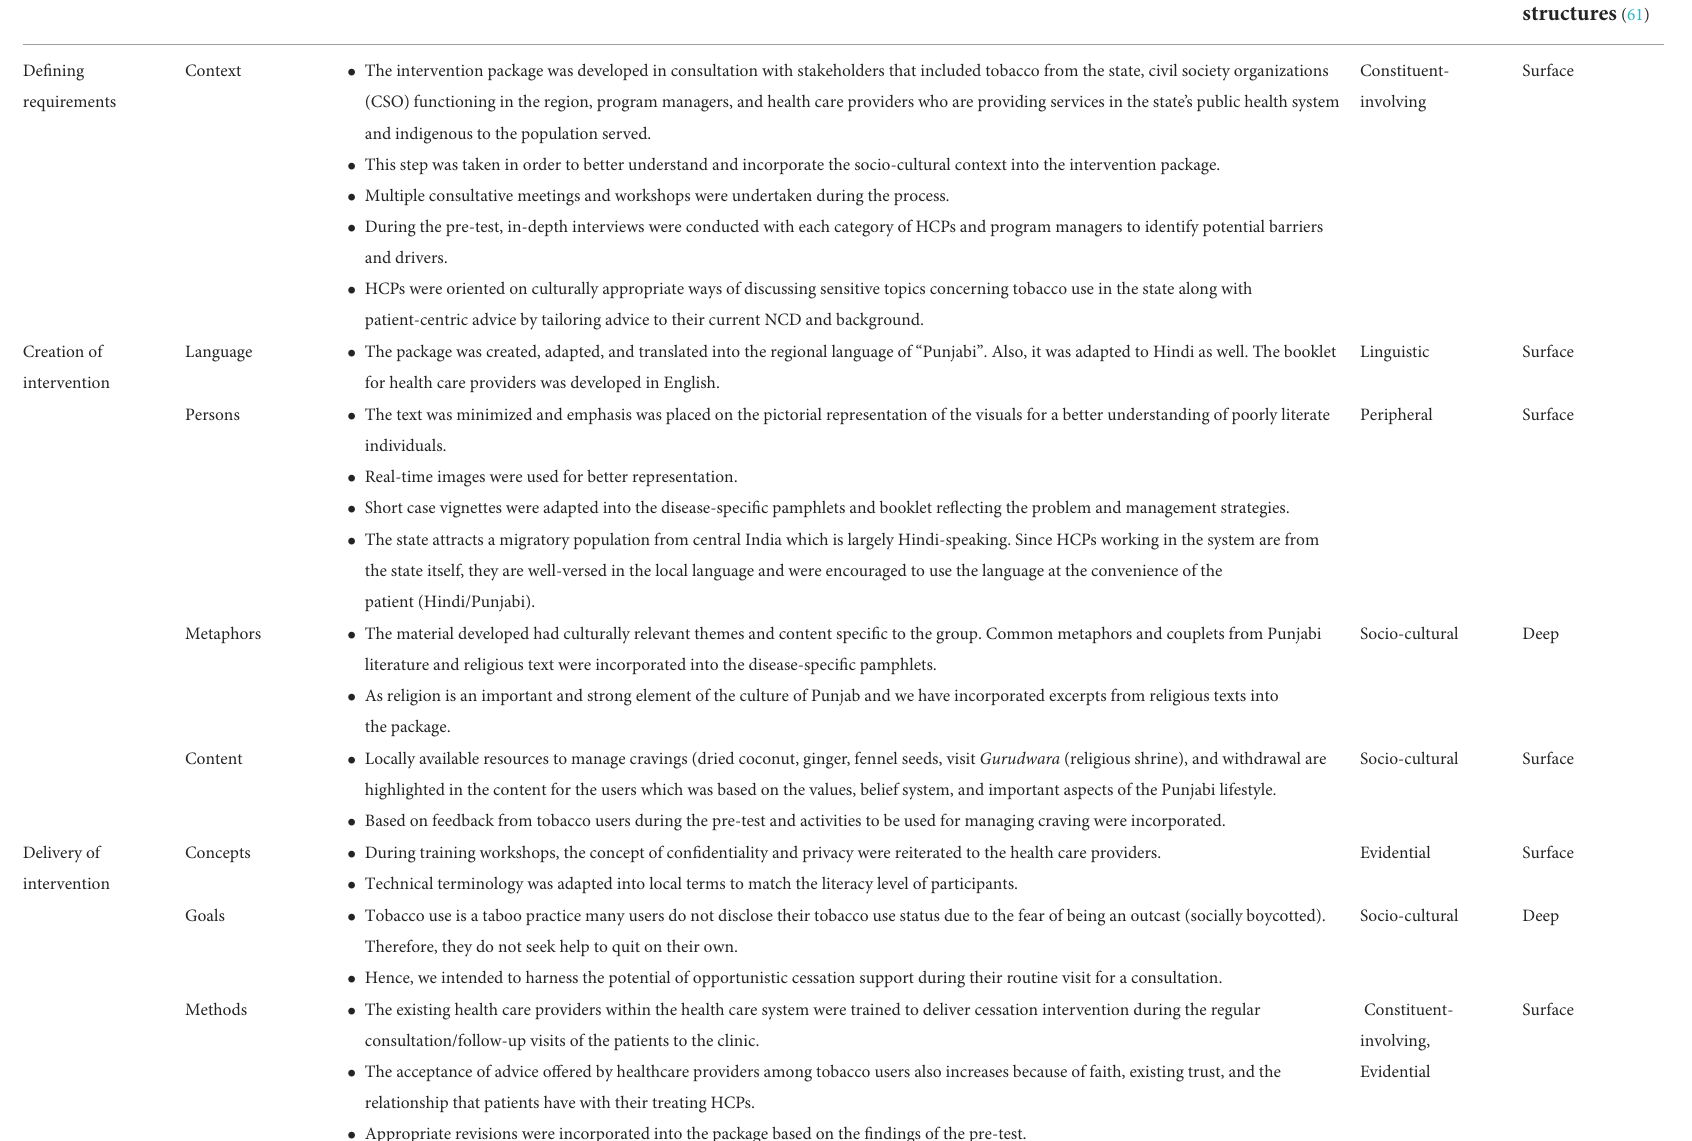
TABLE 3 Intervention package: Stages of development and adaptation.